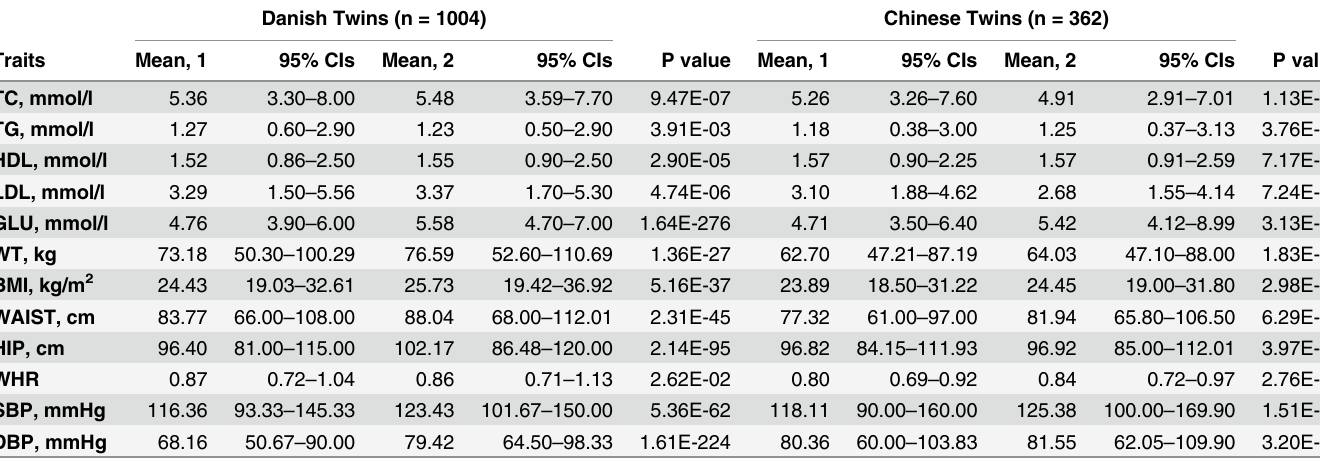
TC: total cholesterol; TG: triglycerides; HDL: high density lipoprotein cholesterol; LDL: low density lipoprotein cholesterol; GLU: fasting blood glucose; WT: body weight; BMI: body mass index; WAIST: waist circumference; HIP: hip circumference; WHR: waist-to-hip ratio; SBP: systolic blood pressure; DBP: diastolic blood